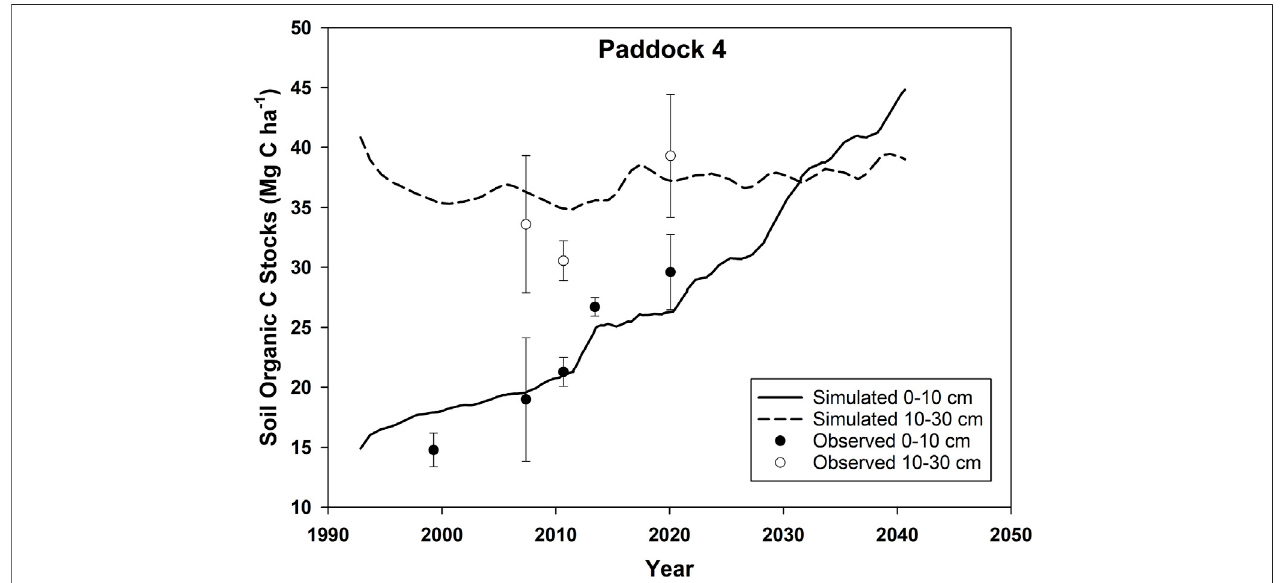
FIGURE4| Simulated andobservedsoilorganiccarbon(SOC) stocksat0 – 10and10 – 30 cmdepths forPaddock 4area,inaTypic Acrustoxsoilunderintegrated crop-livestock system at Santo Antônio de Goiás, GO, Brazil.